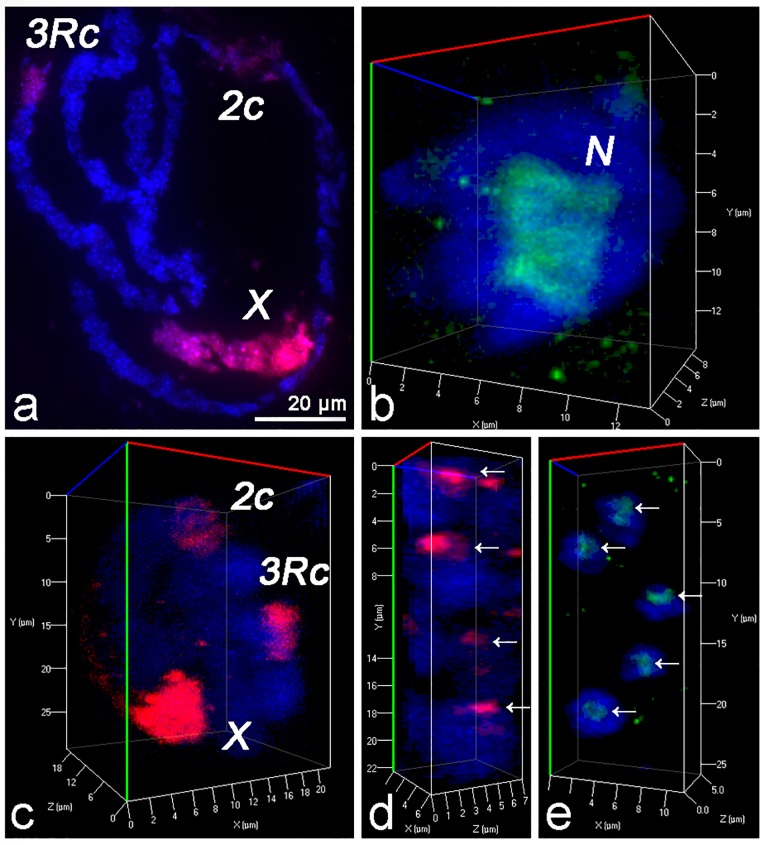
Visualization of the X chromosome and nucleolus in An. atroparvus.a) 2D-FISH of fluorescent X chromosome painting probe with squashed chromosome preparation from NCs. Specific labeling of the X chromosome (X) and unspecific labeling of pericentromeric regions of 3R (3Rc) and 2 (2c) are shown in red. b) Immunostaining of the nucleolus in an NC nucleus with a fluorescently labeled antibody against fibrillarin. The nucleolus (N) is shown in green. c) 3D-FISH of fluorescent X chromosome painting probe with an NC nucleus. d) 3D-FISH of fluorescent X chromosome painting probe with FE (arrows mark specific labeling of the X chromosome). e) Immunostaining of the FE nucleolus with a fluorescently labeled antibody against fibrillarin (arrows show specific labeling of the nucleolus). Chromosomes are stained with DAPI (blue).